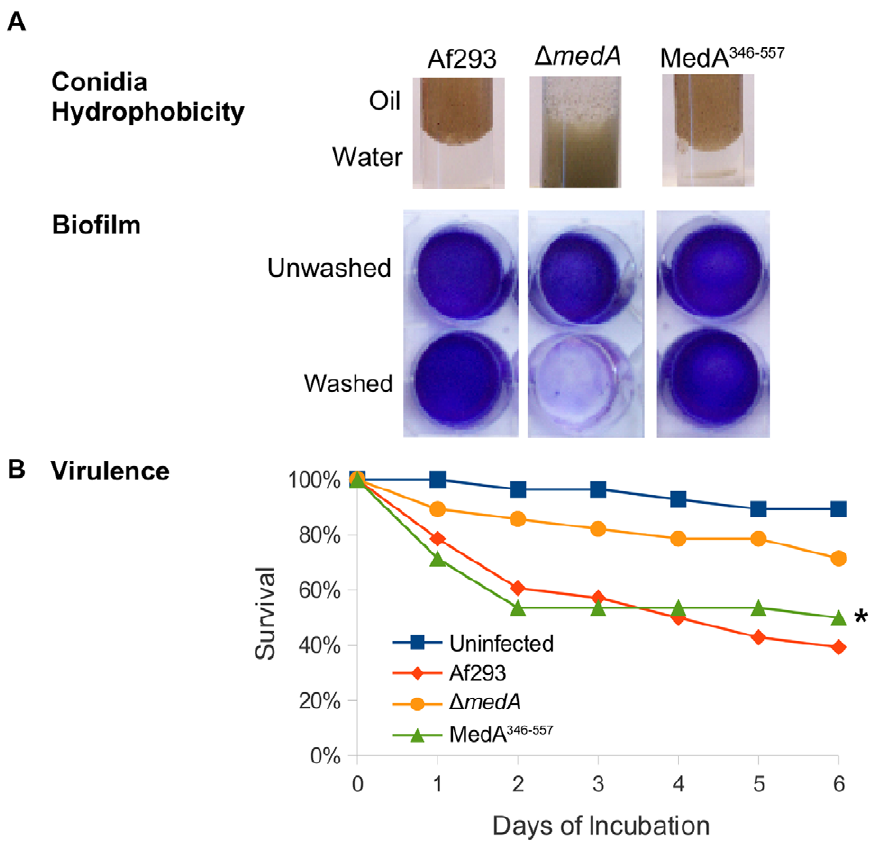
Figure 7. Phenotypic analysis of D medA strain expressing MedA 346–557 domain. (A) Conidia hydrophobicity and biofilm formation of the indicated strains. (B) Survival assay of G. mellonella larvae. 28 worms/strain were infected with 10 5 swollen conidia. Af293 indicates the A. fumigatus wild type strain; MedA 346–557 indicates expression of this construct under the control of the medA(p) in the D medA strain. Analysis of survival data was performed using the log rank test. Statistically significant differences are indicated by asterisk (P value # 0.05).